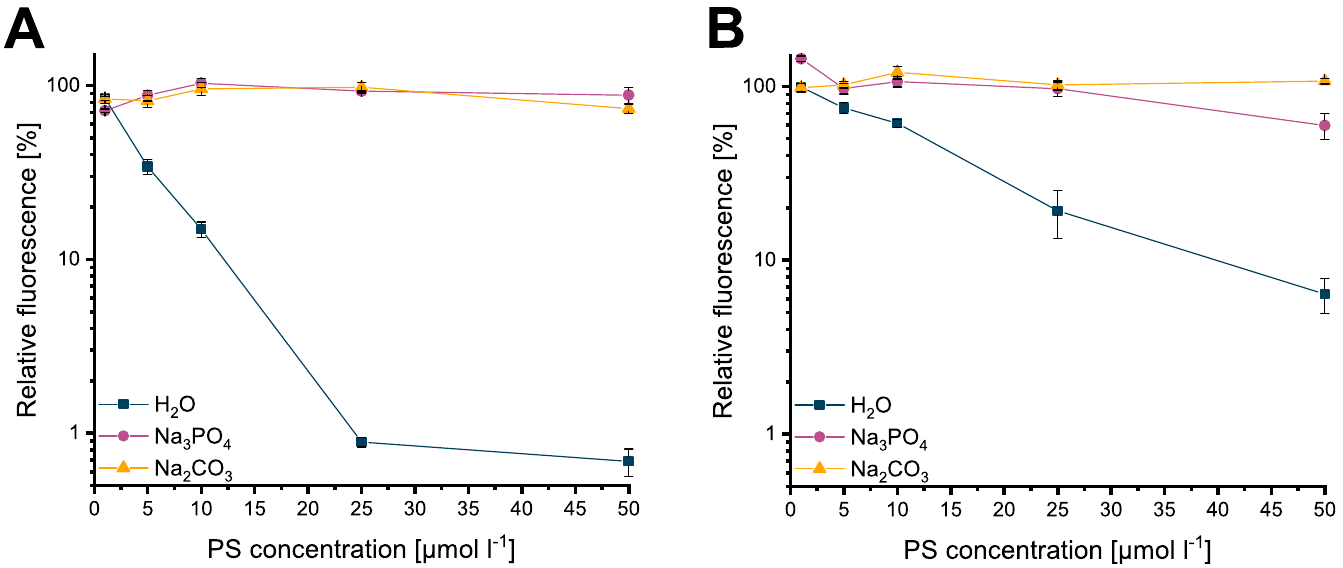
Fig 4. Results for the DPBF assays. Relative fluorescence in presence of FLASH-02a is shown in (A) and FLASH-06a in (B) after 10 s of irradiation. Different colors of the lines and symbols indicate the used environment. In this experiment, 75 mmol l -1 of sodium phosphate or sodium carbonate were applied. Y axes indicate the relative fluorescence in percent referenced to the DPBF control, X axes indicate the PS concentration in μ mol l -1 . Error bars display the calculated standard deviation of the triplicates.